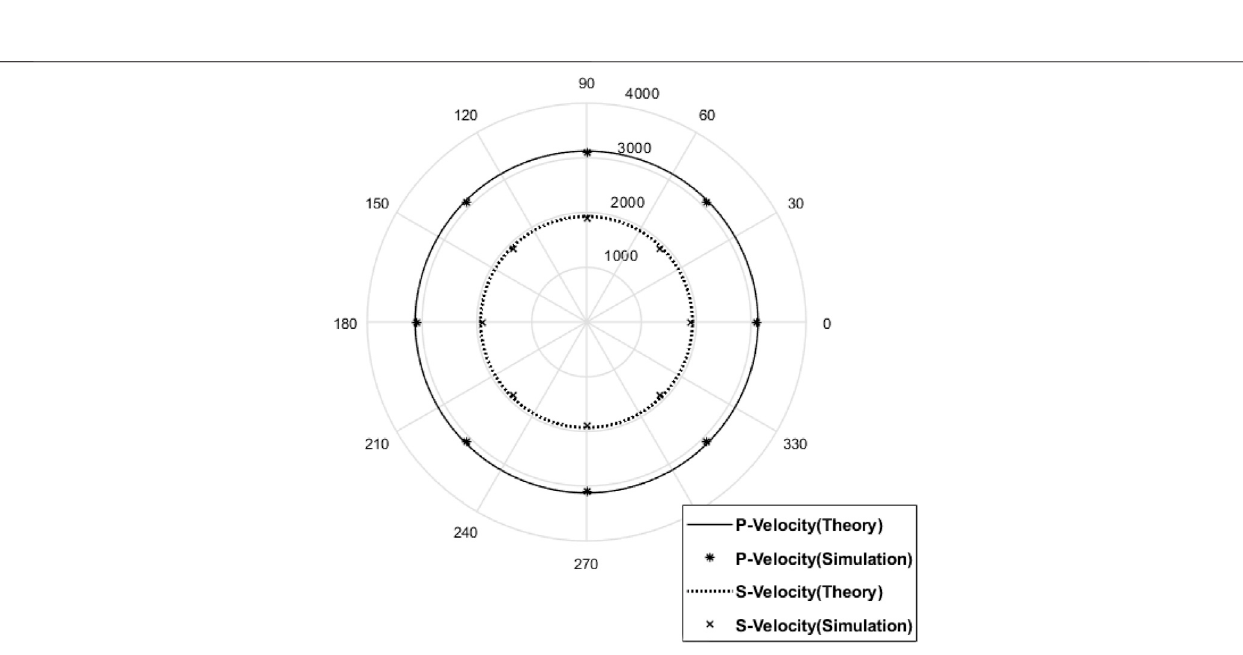
FIGURE 5 | Comparison of the theoretical and calculated wave velocities for both the P-wave and S-wave as a function of hydrostatic prestresses ( θ 1 = 0 ° ).